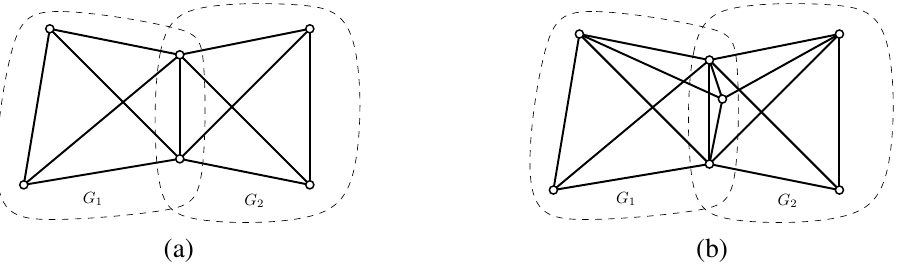
) and ( G , ppp ) can rotate about the line 2 1 2 ) and ( G , ppp ) are glued together along three vertices, and 2 1 2